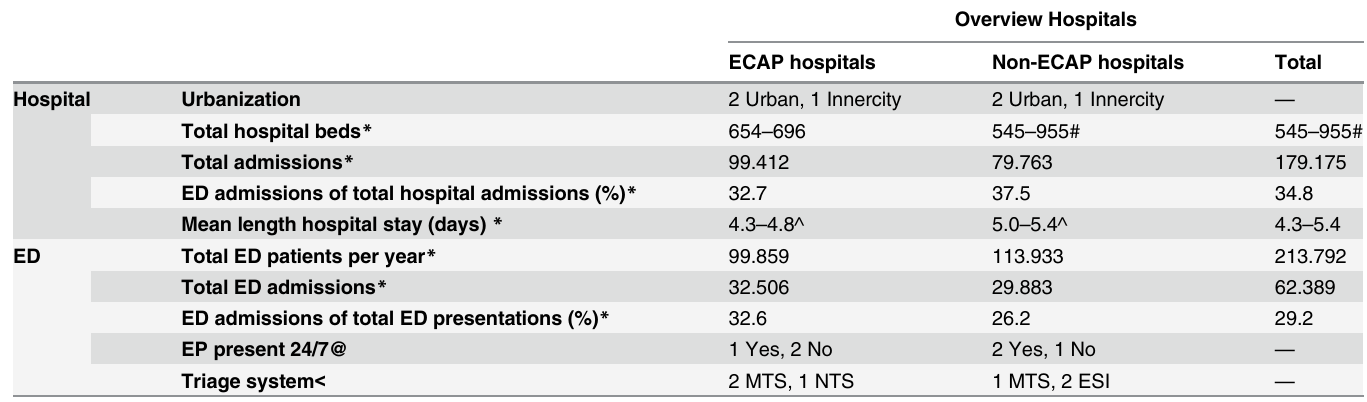
Table 1. Overview of hospital and ED characteristics divided in ECAP and non-ECAP hospitals over